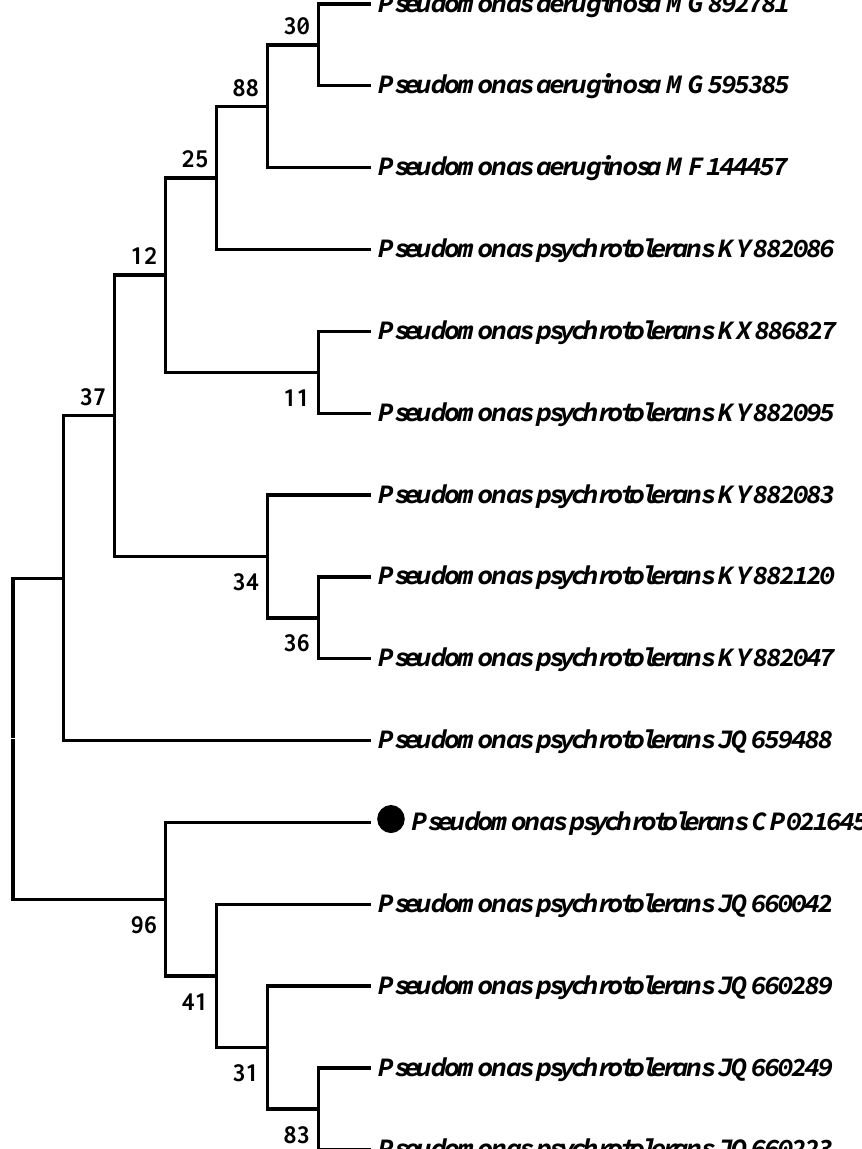
Figure 1. Phylogenetic analysis of Pseudomonas psychrotolerans CS51 with NCBI accession num- ber CP021645.